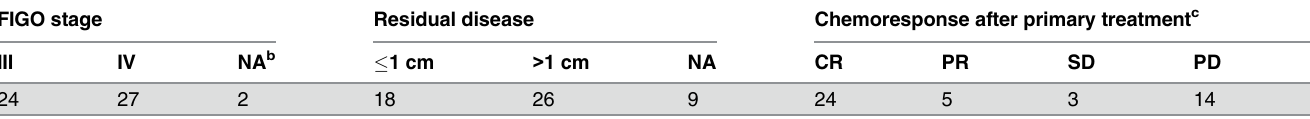
Table 1. Clinicopathologic data of the HGSC effusion cohort (n = 53 patients) a . FIGO stage Residual disease Chemoresponse after primary treatment